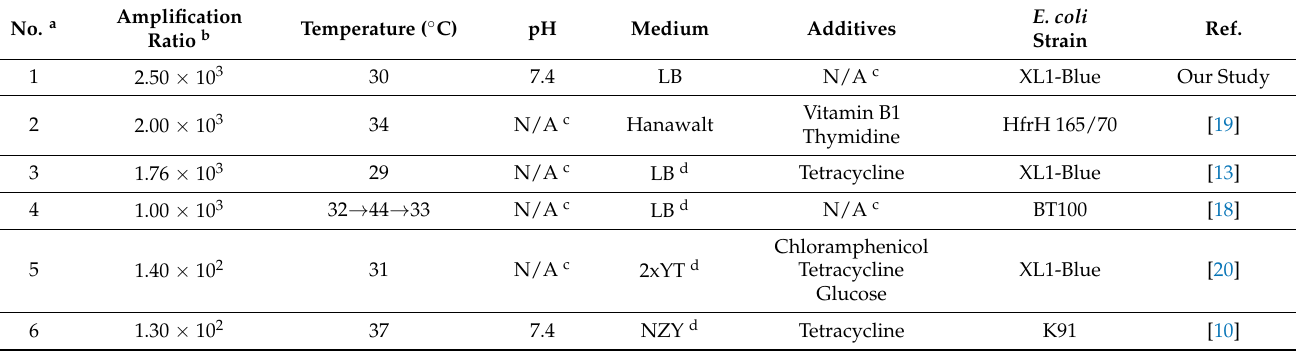
Table 1. Amplification ratios of various M13 bacteriophage production-related